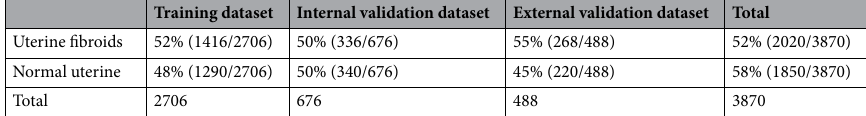
Table 3. The proportion of uterine fibroids to normal uterine ultrasound images in each dataset.